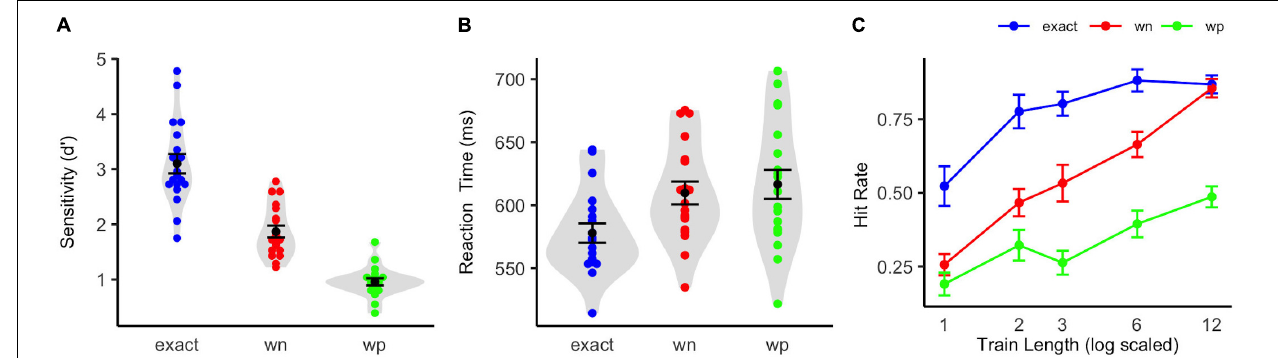
FIGURE 2 | Behavioral performance in the active pattern change detection task. (A) Violin plots show participants sensitivity index d (cid:48) when actively detecting pattern changes in the exact-repetition condition (exact: blue), in the white-noise condition (wn: red), and in the wrong-pitch condition (wp: green). (B) Violin plots show participants reaction times in the active pattern change detection task. The colored dots indicate the results of each single participant ( N = 19). The black dots show the mean of all the participants, and whiskers indicate the corresponding standard error of the mean. The shapes (gray) show the distribution of results over all the participants. (C) Mean proportion of hits for the exact-repetition condition (exact: blue), the white-noise condition (wn: red), and the wrong-pitch condition (wp: green) on deviant sound patterns as a function of the number of preceding standard sound patterns are shown. Whiskers indicate standard errors of